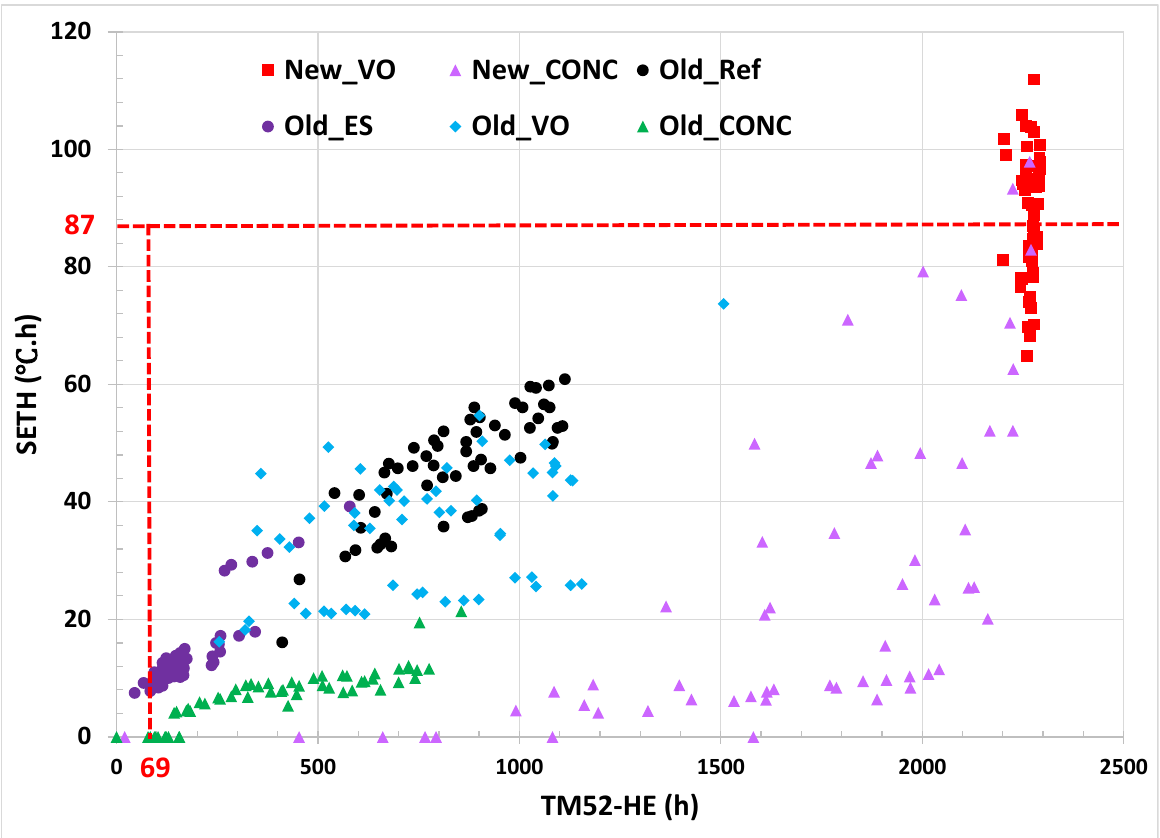
Figure 11. Relationship between SETH and TM52-HE for all bedrooms of old and new LTCHs (note both SETH and HE limit values are shown in the red color; some data points are truncated to fit the axis ranges).